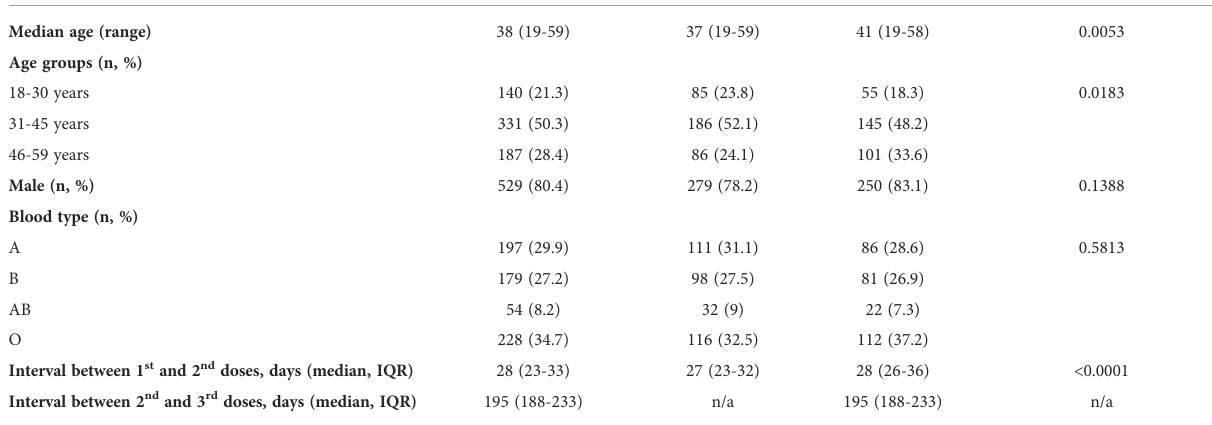
TABLE 1 Characteristics of the participants.